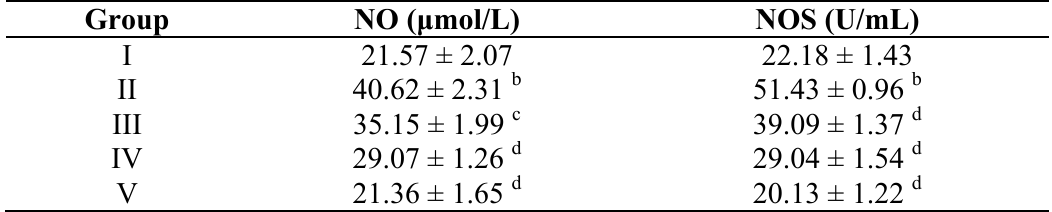
Table 2. Effects of sevoflurane postconditioning on serum NO and NOS concentrations.